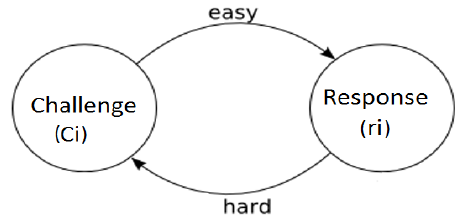
Figure 1. Physical unclonable function concept.